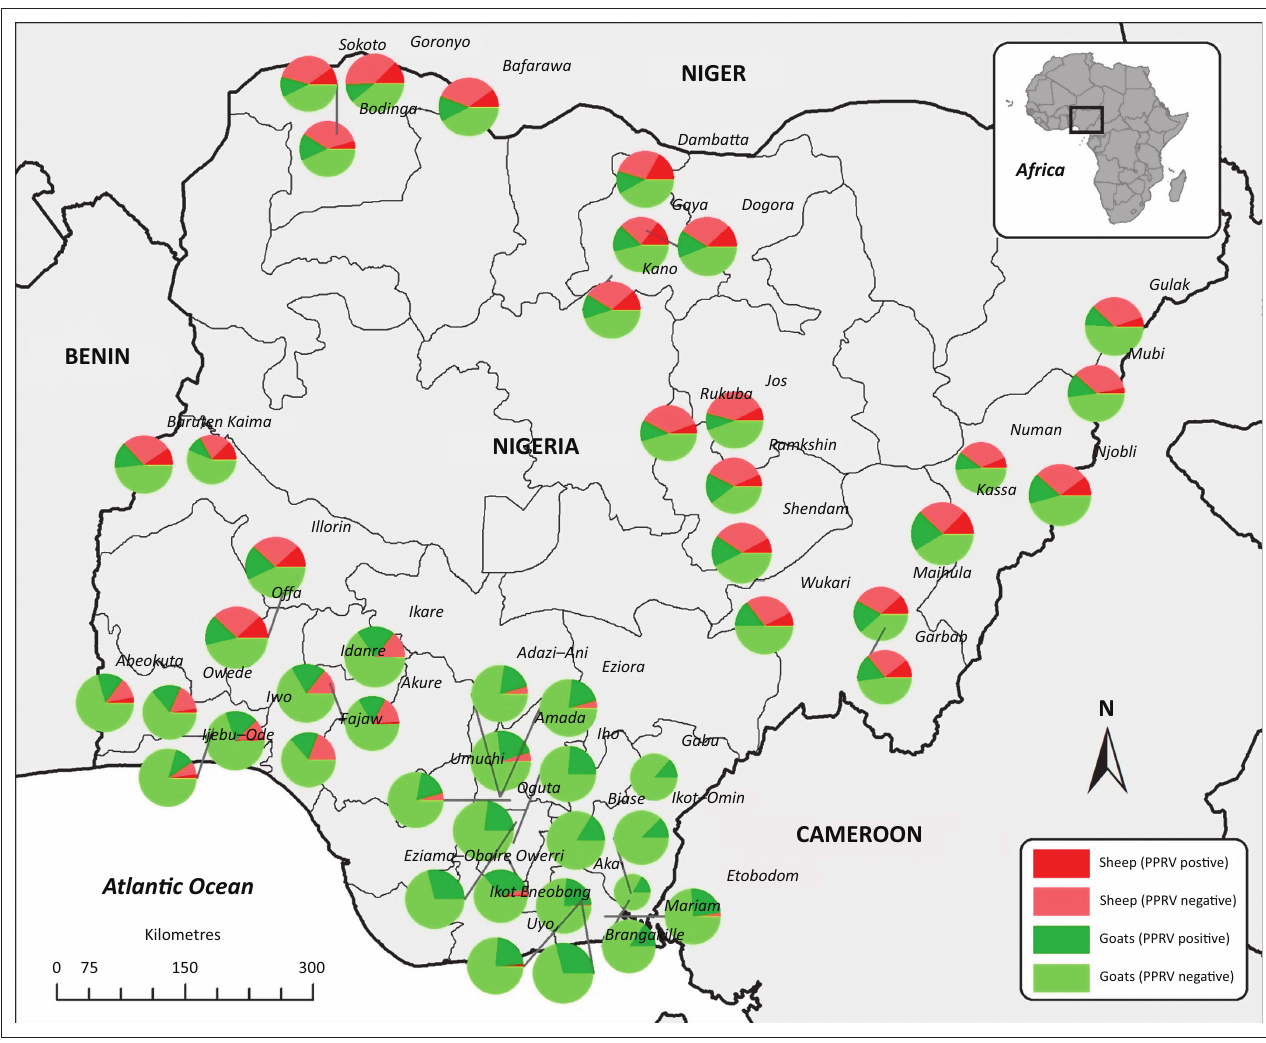
FIGURE 4: The proportion of sheep and goats seropositive to peste des petits ruminants virus in Nigeria. The size of the pie symbol is relative to the number of samples